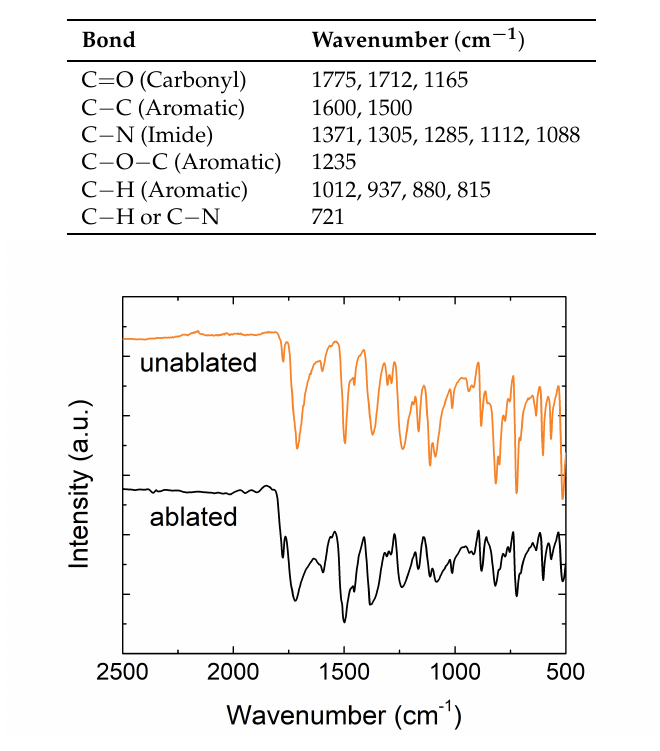
Table 1. Infrared absorption bands’ identification [44].